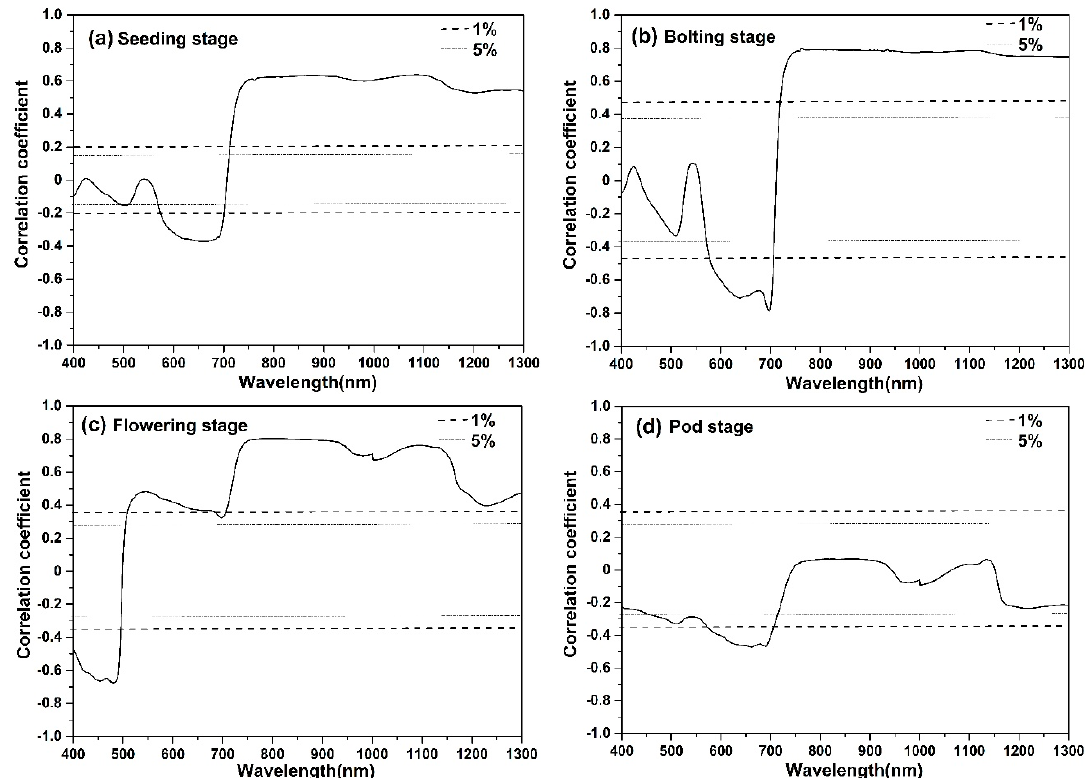
Figure 3. Correlation coefficient results of AGB and canopy spectral reflectance at four different stages: ( a ) Seeding stage; ( b ) Bolting stage; ( c ) Flowering stage; and, ( d ) Pod stage.